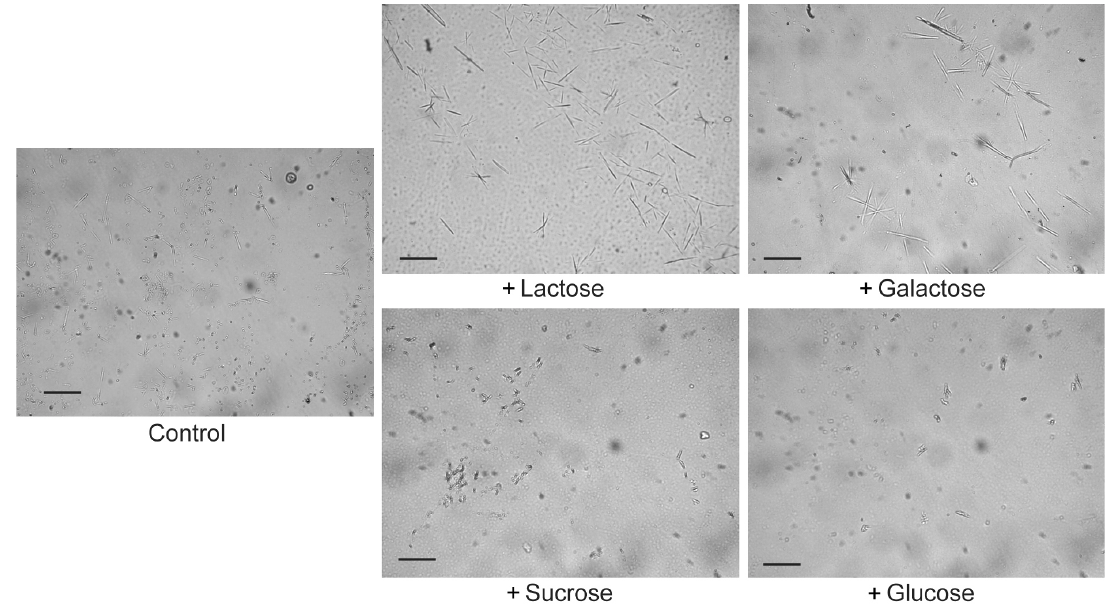
Figure 3. Effects of sugars on Gal-10 crystallization. Gal-10 was diluted to 10 μ M in PBS–azide buffer with 0.01% Coomassie brilliant blue R-250 and incubated with or without 1 mM lactose, galactose, sucrose, or glucose for 24 h. The crystals were observed under a light microscope. Bar = 50 μ M.